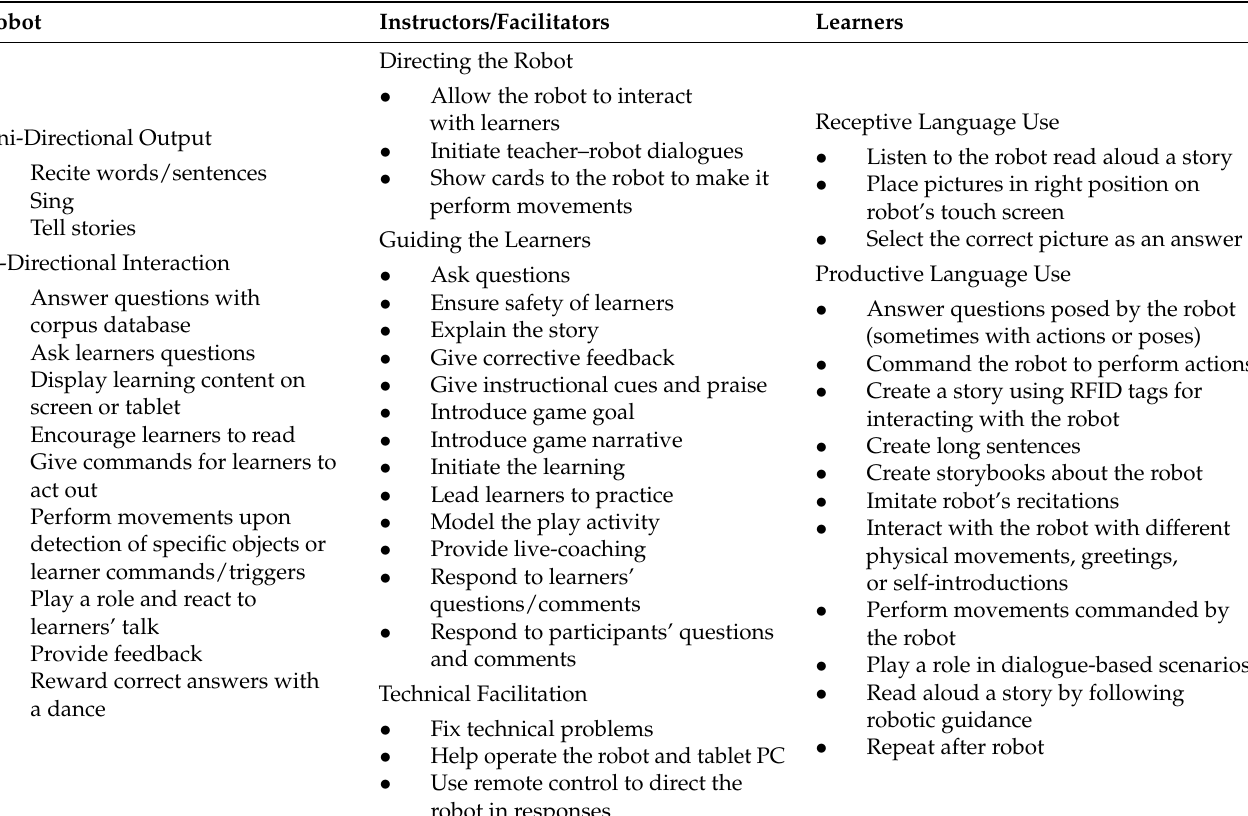
Table 2. Synthesis of Actions Performed by Interacting Agents in